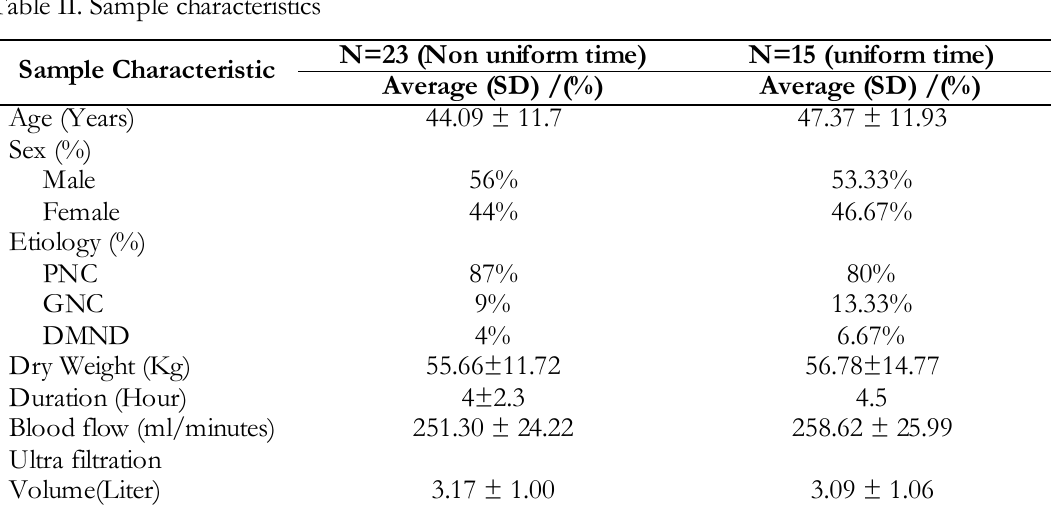
Table II. Sample characteristics